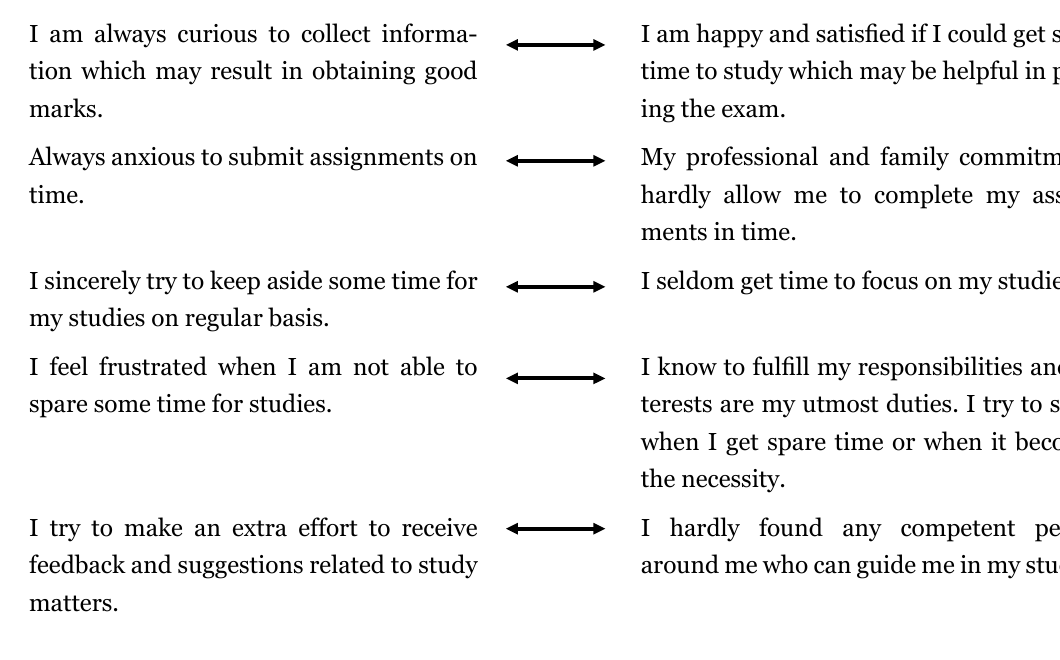
Figure 1 . Some of the statements used in the Academic Motivation